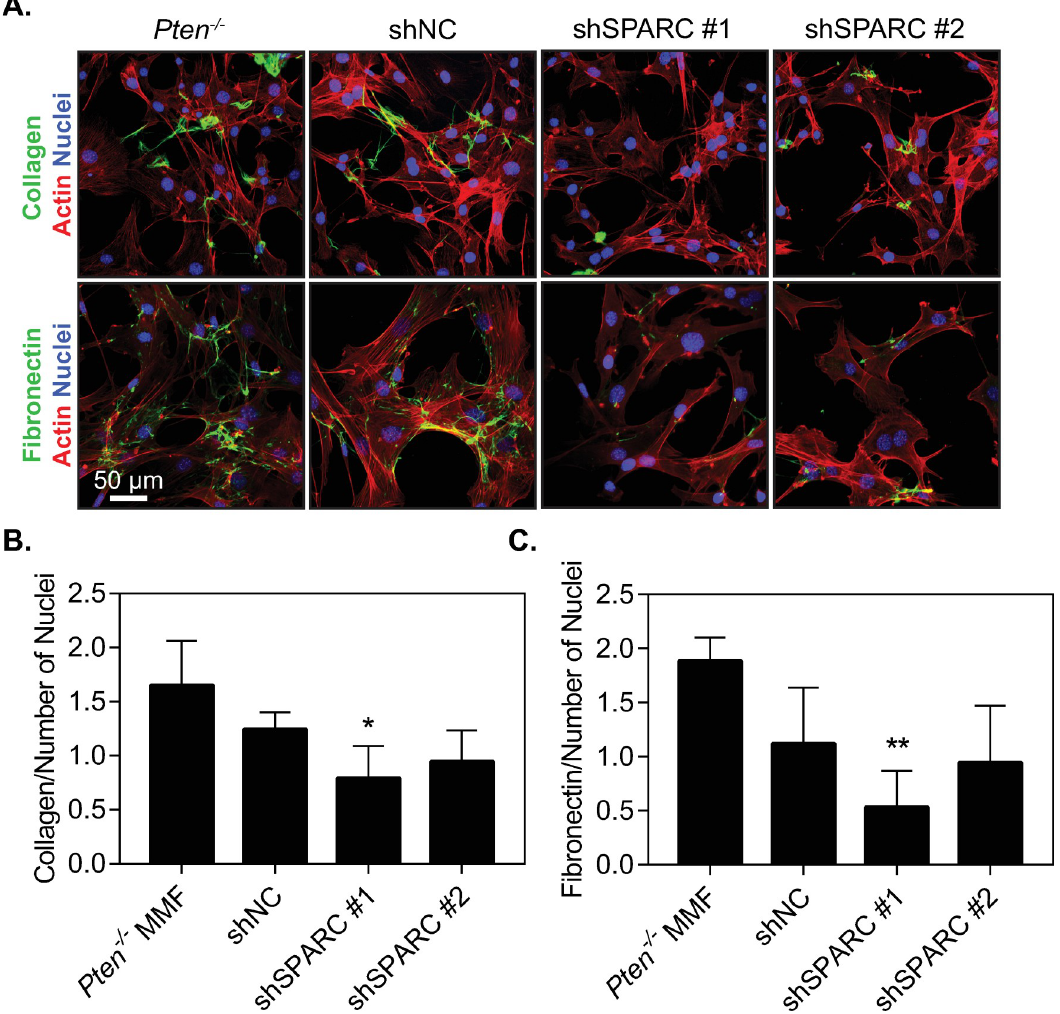
Fig 6. SPARC expression induced by Pten knockout promotes collagen and fibronectin fiber formation. (A) Immunofluorescence images of cells incubated with fluorescently labeled collagen and fibronectin for 24 hours, then fixed and stained for actin and nuclei. (B) Quantification of the area of each image covered by collagen fibers normalized to number of nuclei in each image. (C) Quantification of the area of each image covered by fibronectin fibers normalized to number of nuclei in each image. n = 3+SD. � p < 0.05 relative to Pten -/- . �� p < 0.01 relative to Pten -/-